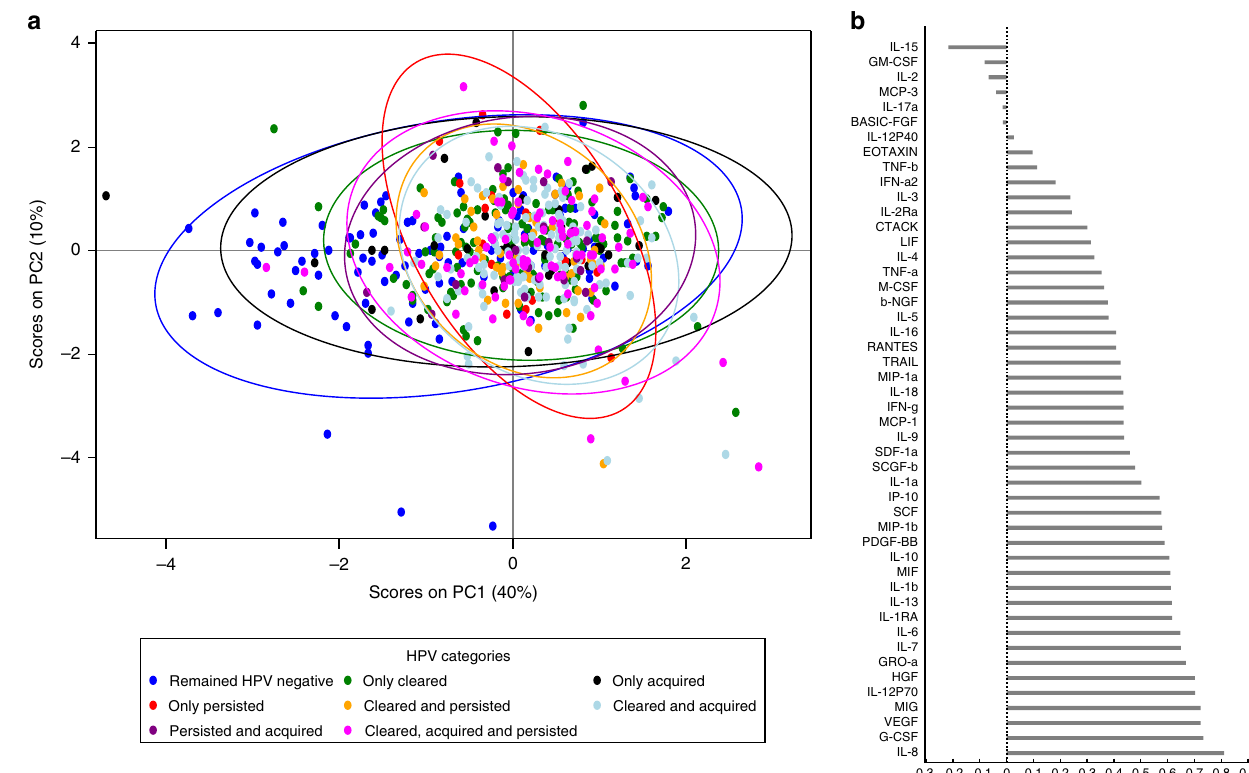
Fig. 6 Principal component analysis (PCA) of the association between HPV infection and genital cytokines. ( a ) Principal component (PC) analysis and ( b ) cytokine loading on PC1 were used to de fi ne the relationship between HPV status and genital cytokine concentrations observed between two consecutive visits for all HIV-negative study participants ( N = 673 visits). Each dot in the plot represents a participant ’ s score, which indicates individual standing on each component, and different colors indicate the HPV category of each participant. Participants with higher scores in PC1 are expected to have a higher level of certain cytokines as those load higher in PC1; e.g.